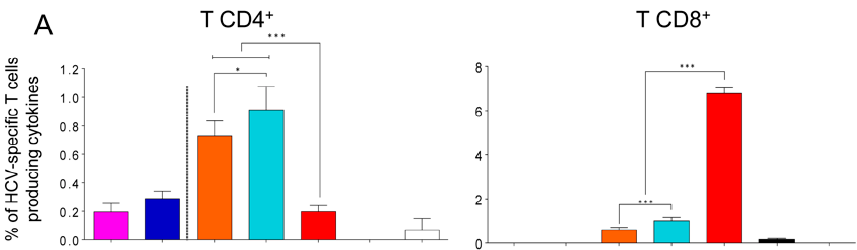
Figure 5. Memory CD4 + and CD8 + HCV-specific T cell immune responses in immunized mice. p values indicate significant response di ff erences between immunization groups (* p < 0.05; ** p < 0.005;